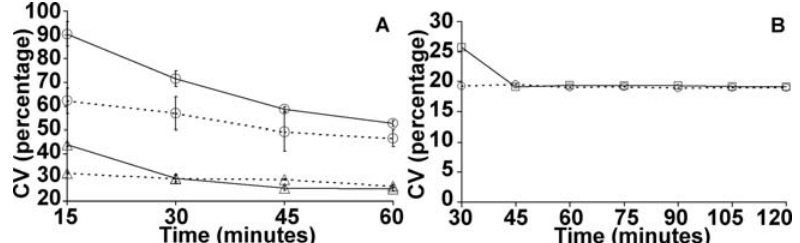
Figure 10. Coefficient of Variation for both Basic (dashed lines) and Delay (solid lines) circuits: A) Experimental populations for different inducer concentrations (25 ng/ml -circles, and 75 ng/ml -triangles ) till 60 min from three experiments, and B) Theoretical simulation (Basic: dashed line and Delay: solid line). doi:10.1371/journal.pone.0002972.g010 Table 1. A survey of negatively auto-regulated operons in E coli .